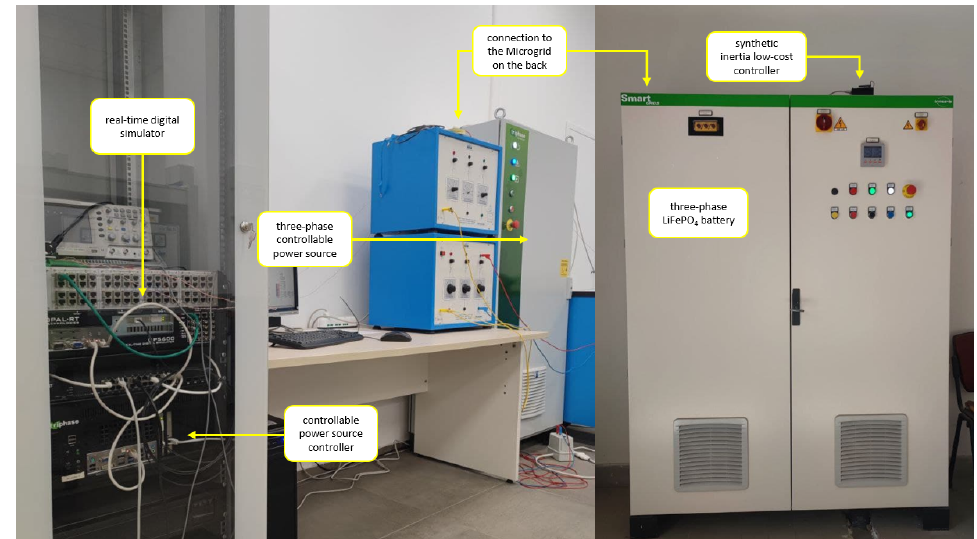
Figure 2. Power hardware-in-the-loop test equipment.